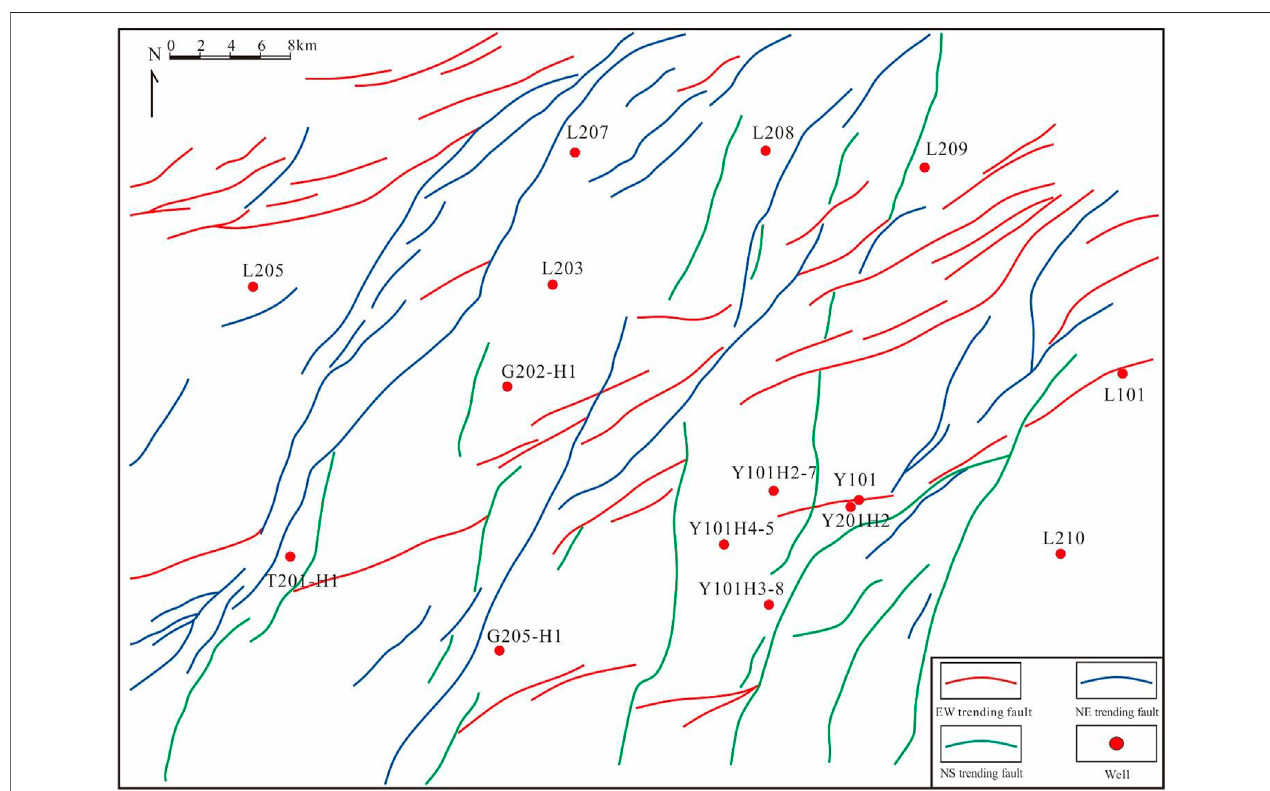
FIGURE 6 | Distribution of the fault system in the Longmaxi Formation of the Luzhou